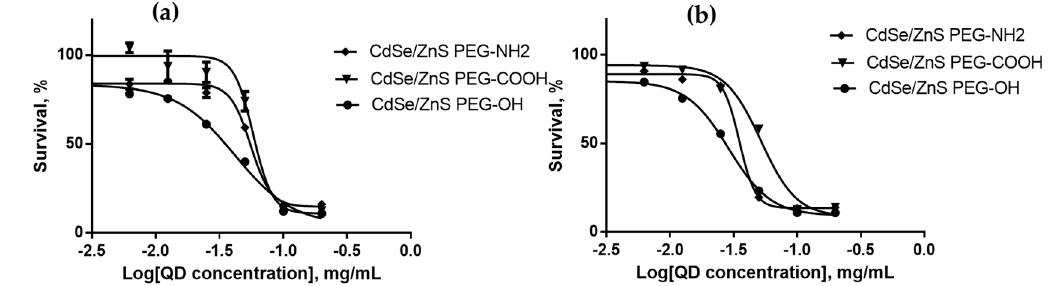
Figure 4. Survival of WI-38 cells upon interaction with CdSe/ZnS-PEG-OH, CdSe/CdS/ZnS (6+3 ML)-PEG-OH, and CdSe/CdS (8 ML)-PEG-OH QDs for ( a ) 24 and ( b ) 48 h as dependent on the QD concentration.